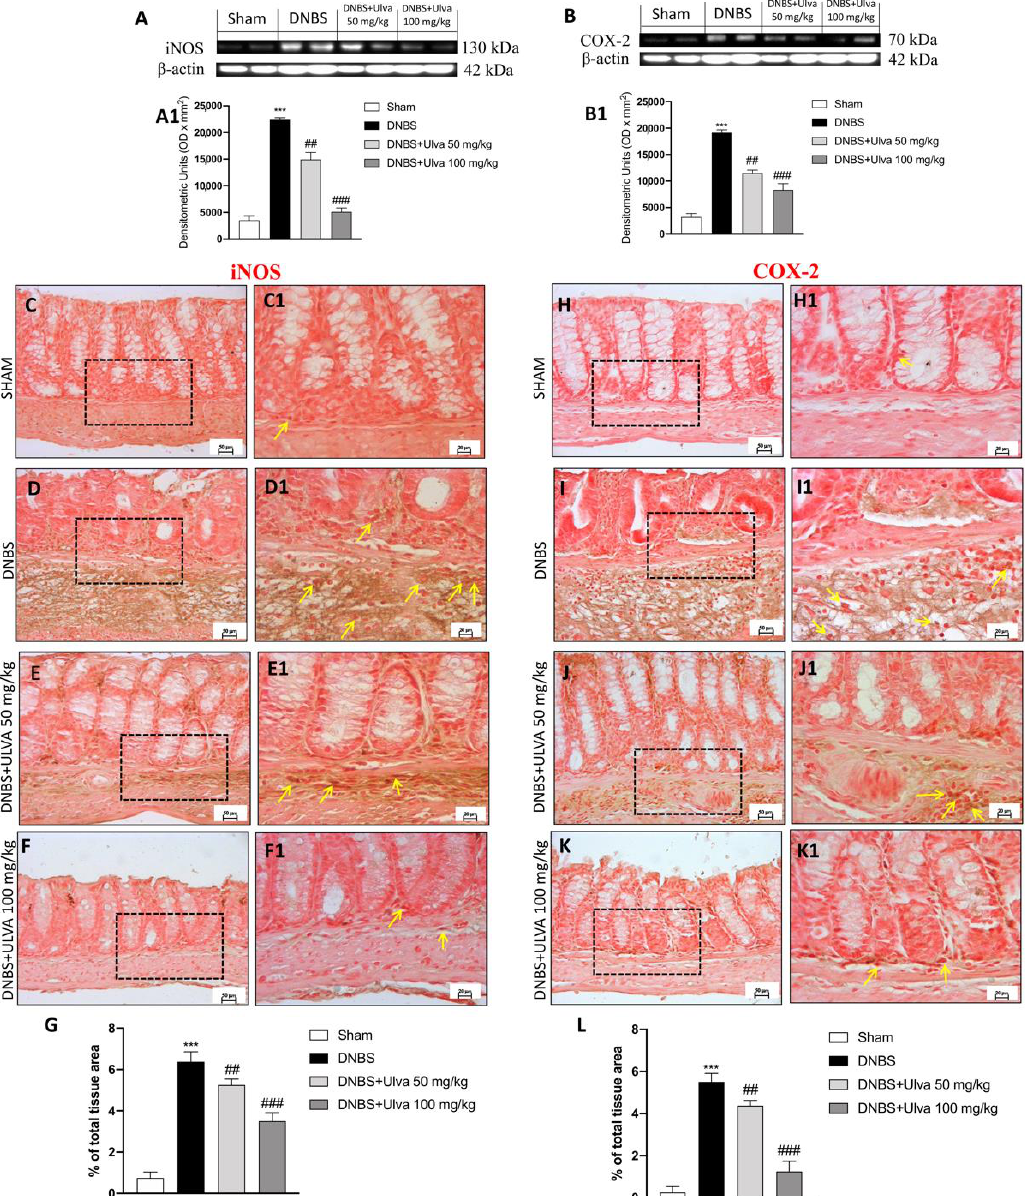
Figure 4. Effect of Ulva pertusa on pro-inflammatory mediators COX-2 and iNOS. Colon tissues collected from DNBS injected animals showed positive immunostaining for iNOS ( D , D1 ), score ( G ), compared to the sham group ( C ), 40 × magnification ( C1 ), score ( G ). Ulva pertusa administration notably reduced such expression in a dose-related manner ( E ), 40 × magnification ( E1 ), ( F ), 40 × magnification ( F1 ), score ( G ). Western blot analysis confirmed immunohistochemical results ( A ), densitometric analysis ( A1 ). Tissues from animals injected with DNBS showed positive immunostaining for COX-2 ( I , I1 ), score ( L ) compared to the sham group ( H ), 40 × magnification ( H1 ), score ( L ). Administration of Ulva 50 mg/kg reduced this expression ( J ), 40 × magnification ( J1 ), score ( L ), although less effectively than Ulva 100 mg/kg ( K ), 40 × magnification ( K1 ), score ( L ). Western blot analysis of COX-2 levels confirmed the data ( B ), densitometric analysis ( B1 ). Yellow arrows indicate the positive staining for iNOS and COX-2. Data are representative of at least three independent experiments. Values are means ± SD. One-way ANOVA test followed by Bonferroni. *** p < 0.001 vs. Sham; ## p < 0.01 vs. DNBS; ### p < 0.001 vs.